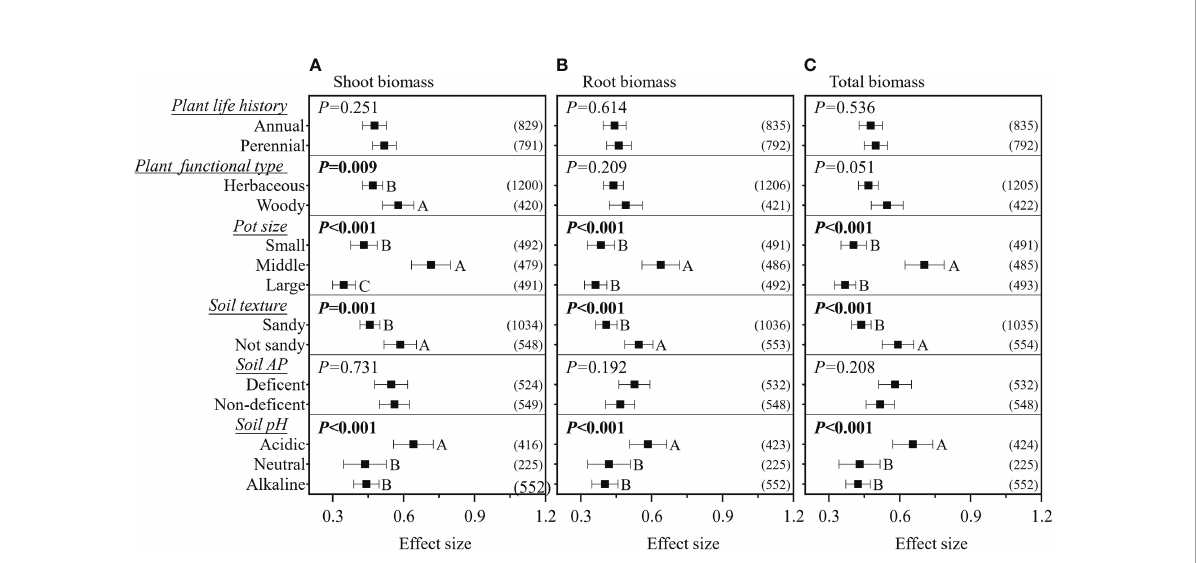
FIGURE 4 Effect of plant life history, plant functional type, pot size, soil texture, soil available phosphorus (AP), and soil pH on the effect size of arbuscular mycorrhizal fungi (AMF) on plant shoot (A) , root (B) , and total (C) biomass. Values in parentheses are the number of observations included in the analysis. The signi fi cance test for between-level differences was based on a random effects model with a residual maximum likelihood (REML) method. P -values ≤ 0.05 were considered signi fi cant. Different capital letters indicate signi fi cant differences compared with the other groups as assessed using a random effects model with a REML method.